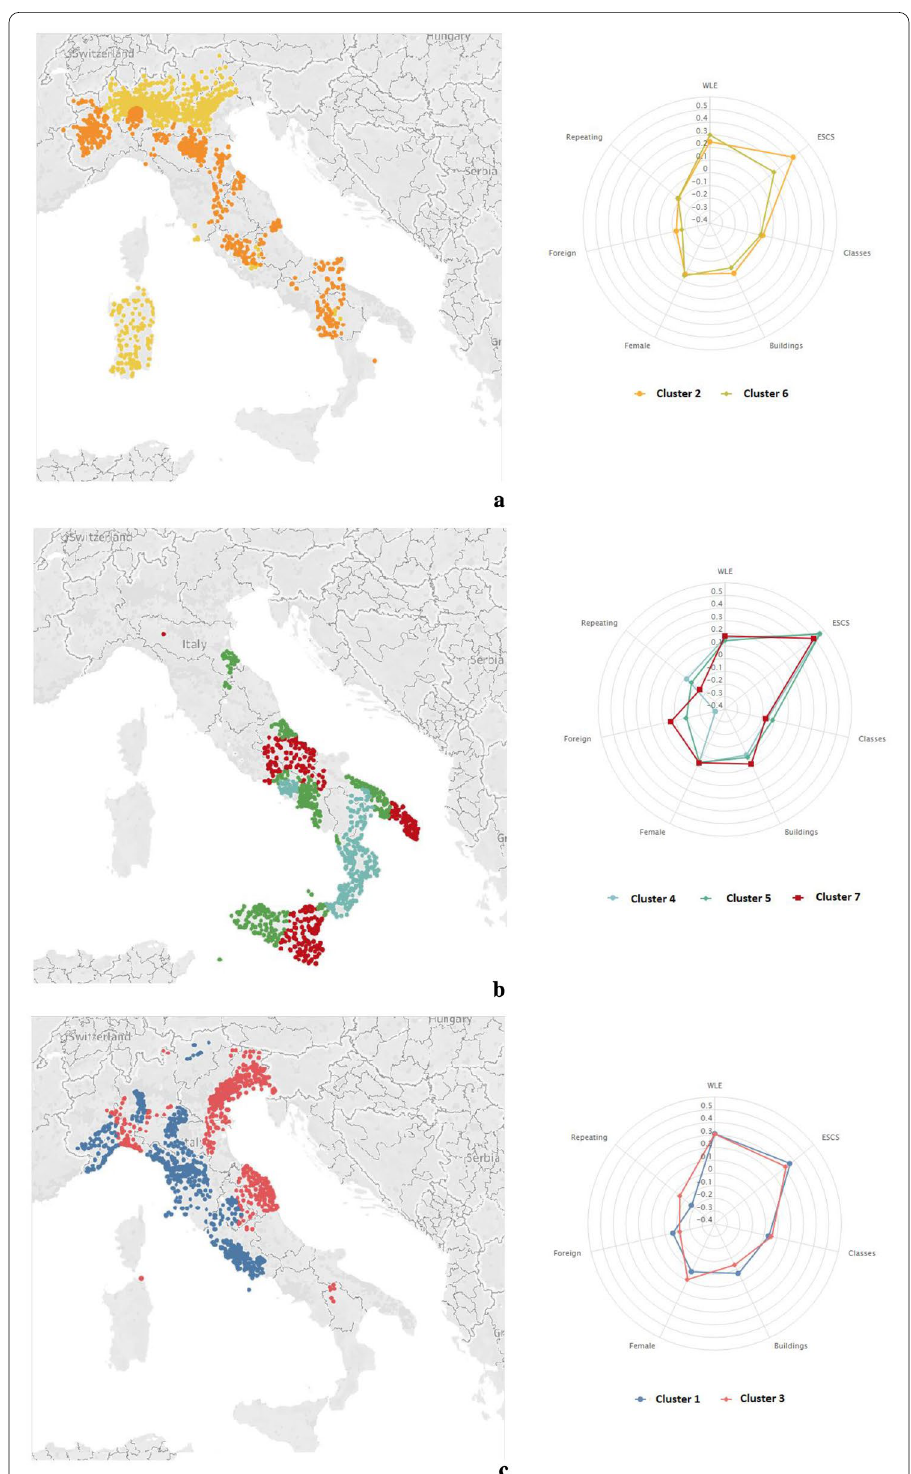
Fig. 3 Map and radar plot of Italian school